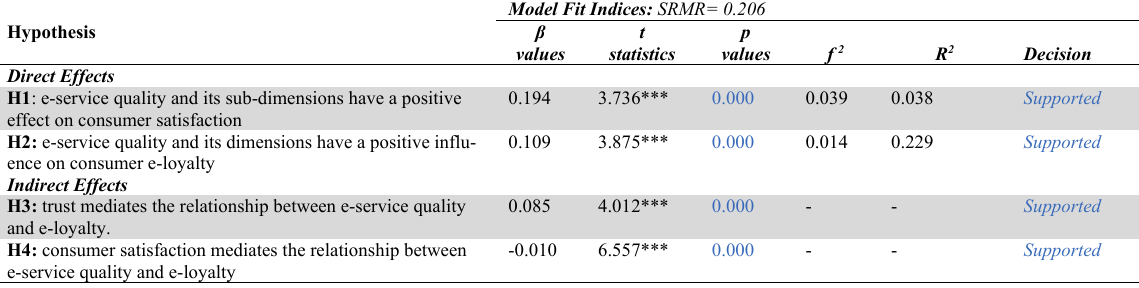
Model Fit Indices: SRMR= 0.206 t p values statistics values f 2 R 2 Decision